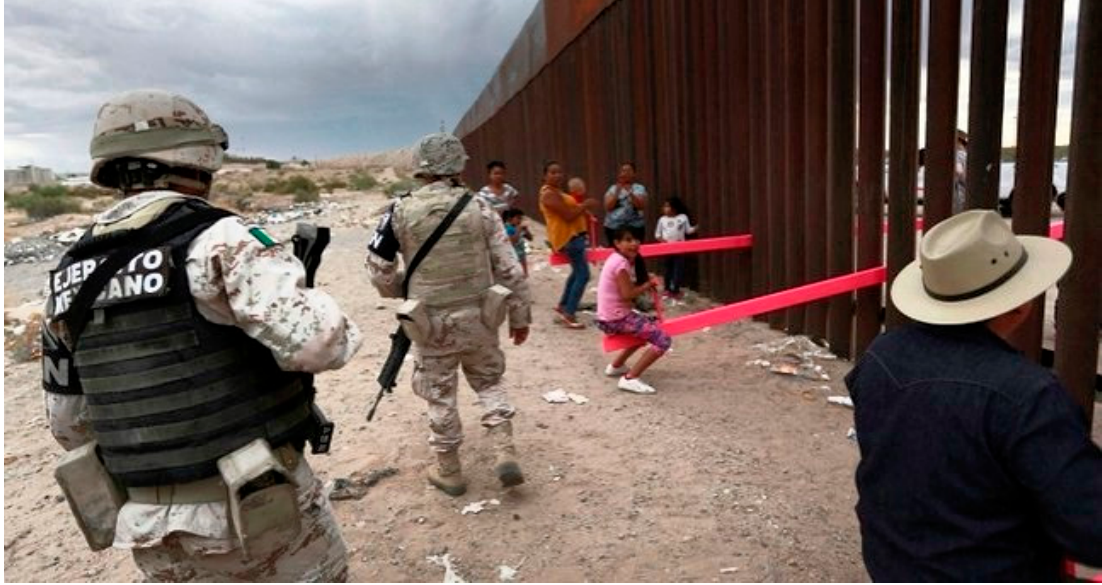
Figure 13. Border security observes art installation (Photo graciously provided by Ronal Rael).